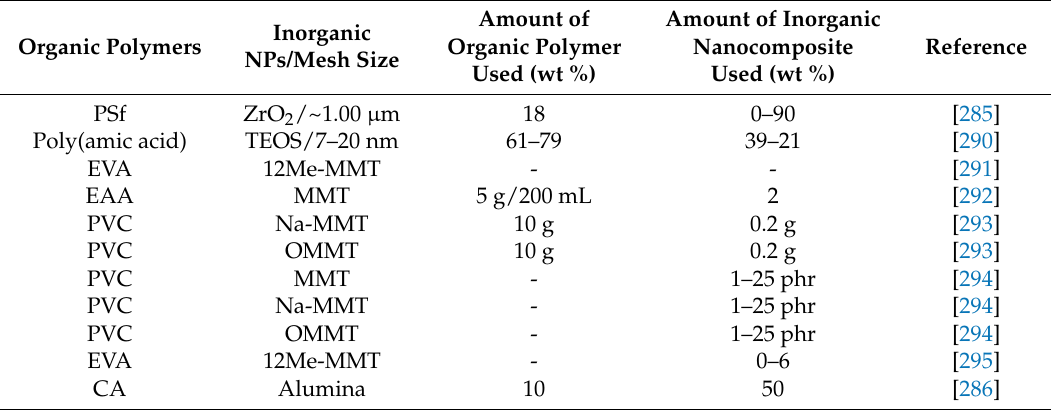
Table 1. Fabrication of nanocomposite polymeric membranes by solution blending method.